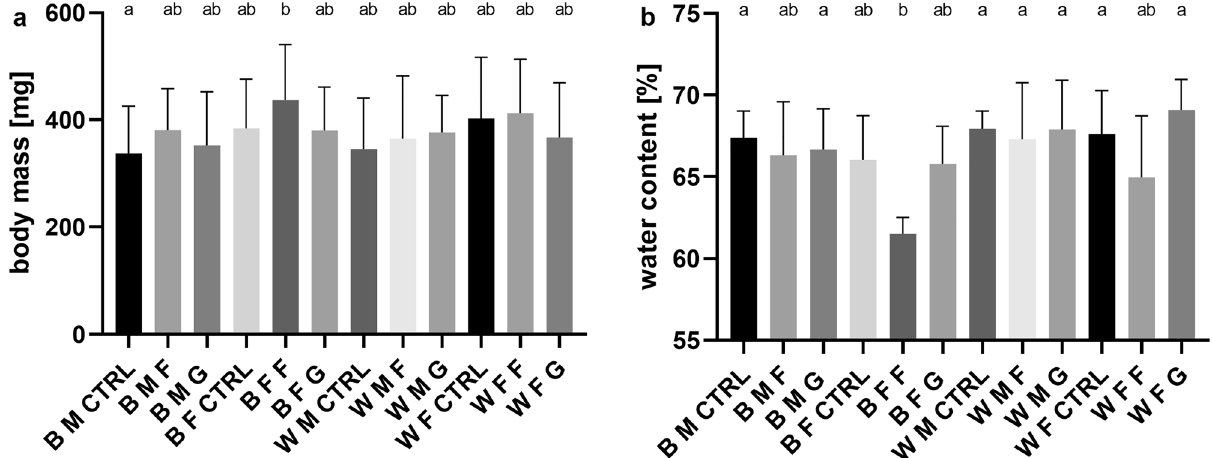
Figure 7. Effects of HMD on imagoes body mass and water content (mean ± SD). ( a ) Imago body mass (fresh body weight) for both sex and strains after HMD treatment (minimum n = 10). One-way ANOVA F (11, 247) = 2.195, P = 0.0153. ( b ) Water content (percentage of fresh body mass) for imagos of both sex and strains after HMD treatment (n = 6). One-way ANOVA F (11, 60) = 3.397, P = 0.0011. B black-eyed strain, W white-eyed strain, M males, F females, CTRL control group, F fructose, G glucose. Different letters denote groups differing significantly, Tukey’s multiple comparisons test, P <